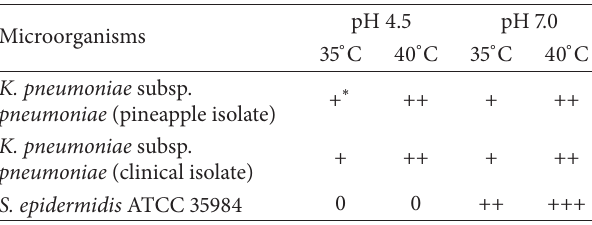
Table 1: Biofilm formation by microorganisms on glass in different pH and